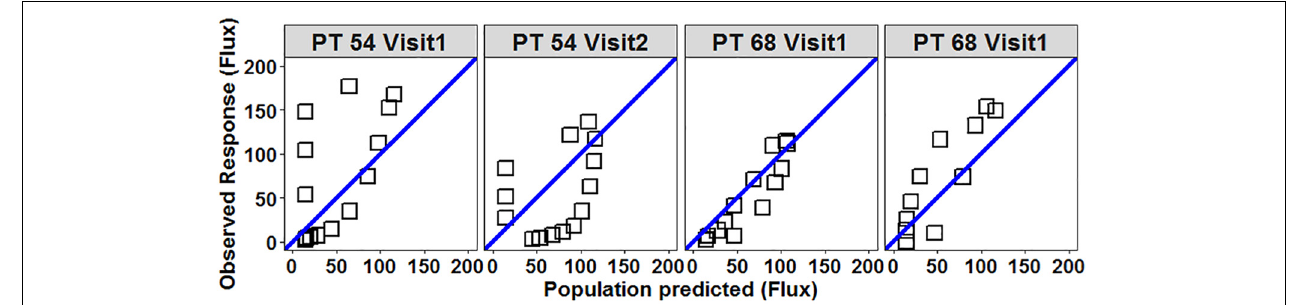
FIGURE 3 | Scatterplot of observed vs. population predicted flux (response) for participants 54 and 68 demonstrate variability between measurements. Open squares represent individual flux values collected during each HILD measurement. Blue line is the line of unity. Participant 54 – on Visit 1 the mean of residuals was +26.5 (classified as hyper-responsive) and on Visit 2 the mean of residuals was –24.4 (classified as hypo-responsive). Participant 68 – on Visit 1 the mean of residuals was –7 (classified as normo-responsive) and on Visit 2 the mean of residuals was +20.8 (classified as hyper-responsive).